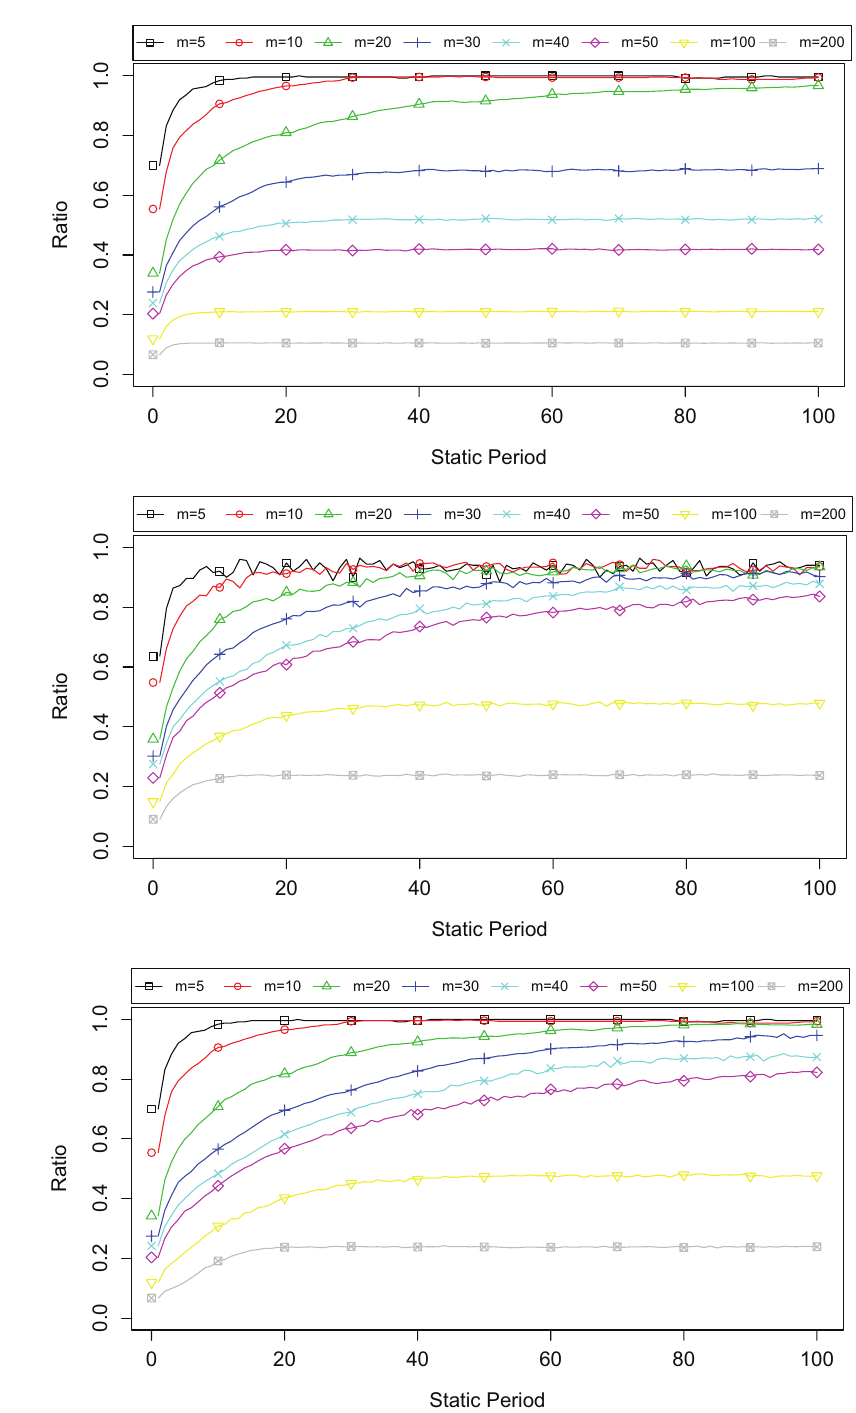
Fig. 4. Evolution of the mean ratio between the number of peaks tracked in each static period and the total number of peaks in the corresponding MPB configuration ( peaks tracked and AR (C). The static period and the mean ratio are represented in the x and y axis, respectively. The eight series corresponds to the eight MPB configurations with different number of peaks ( m